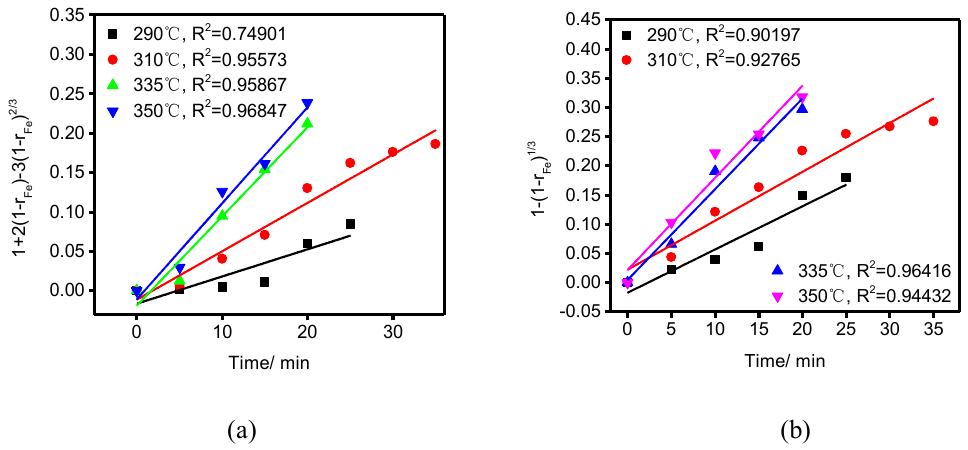
Figure 12. Comparison of plots of (a) 1 + 2(1 − r Fe ) − 3(1 − r Fe ) 2/3 and (b) 1 − (1 − r Fe ) 1/3 vs time Figure 12; Comparison of plots of (a) 1 + 2(1 − r